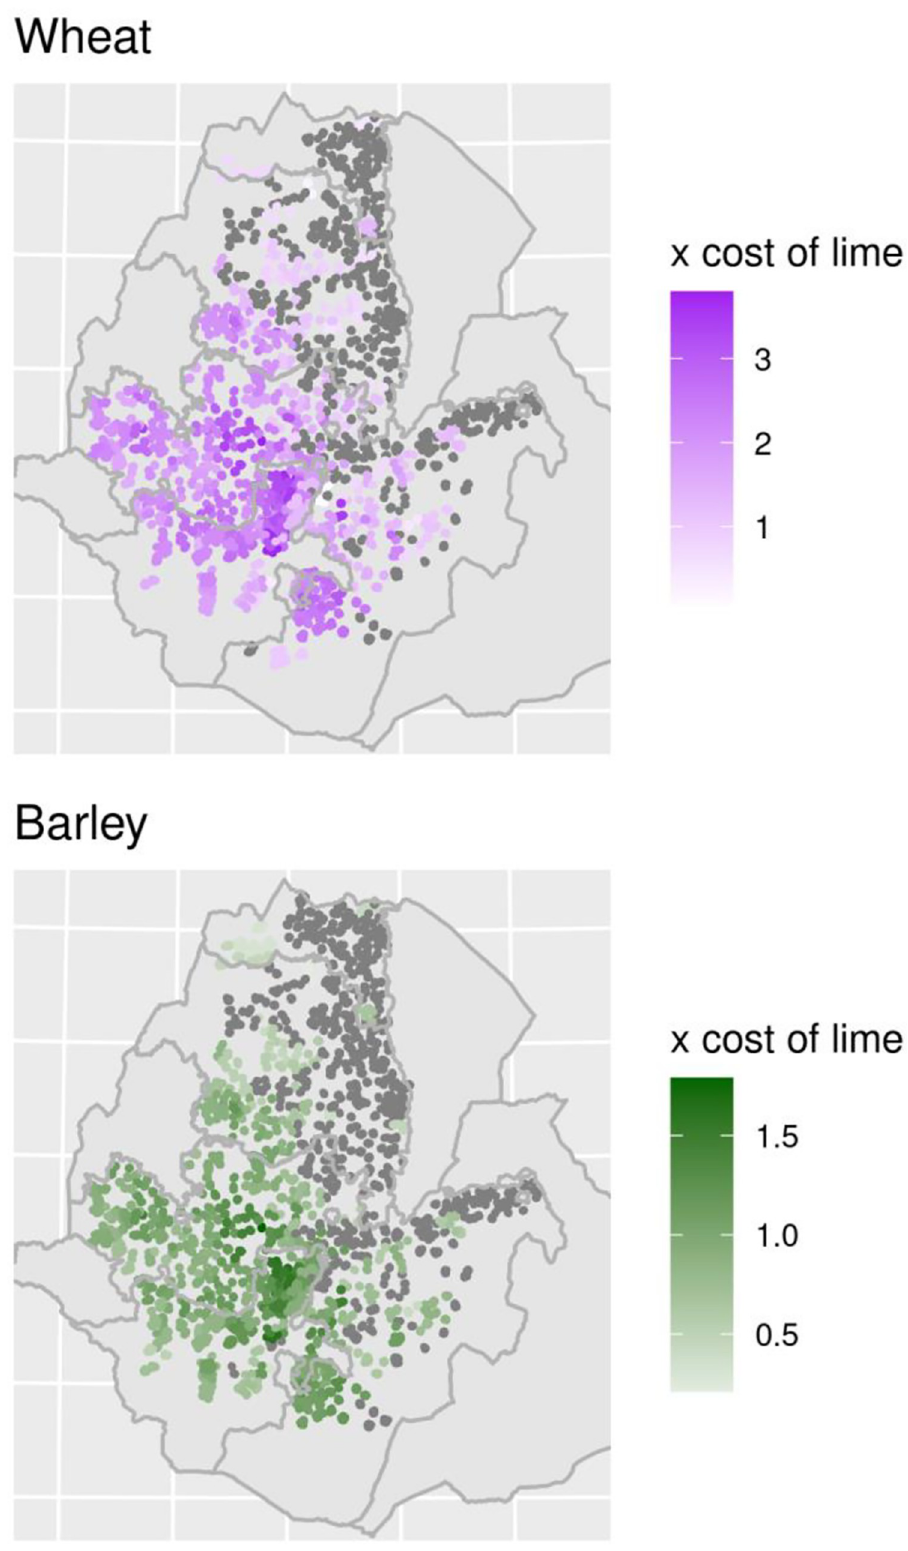
Fig 9. Present value ratios of fertilizer relative to lime application for wheat and barley. Contains information from OpenStreetMap and OpenStreetMap Foundation, which is made available under the Open Database License. https://doi.org/10.1371/journal.pone.0280230.g009 PLOS ONE | https://doi.org/10.1371/journal.pone.0280230 January 12,